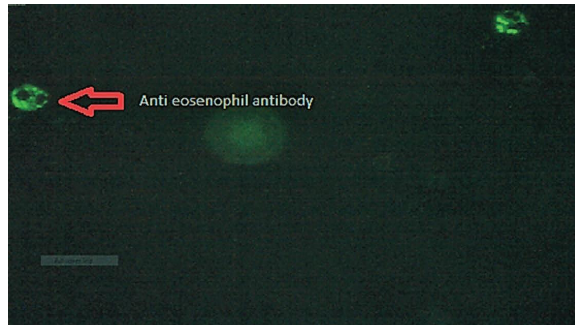
Figure 2: Eosinophilic cytoplasmic reaction patterns by the im- munofuorescence IIF assay using granulocyte biochips from AESKU diagnostics.